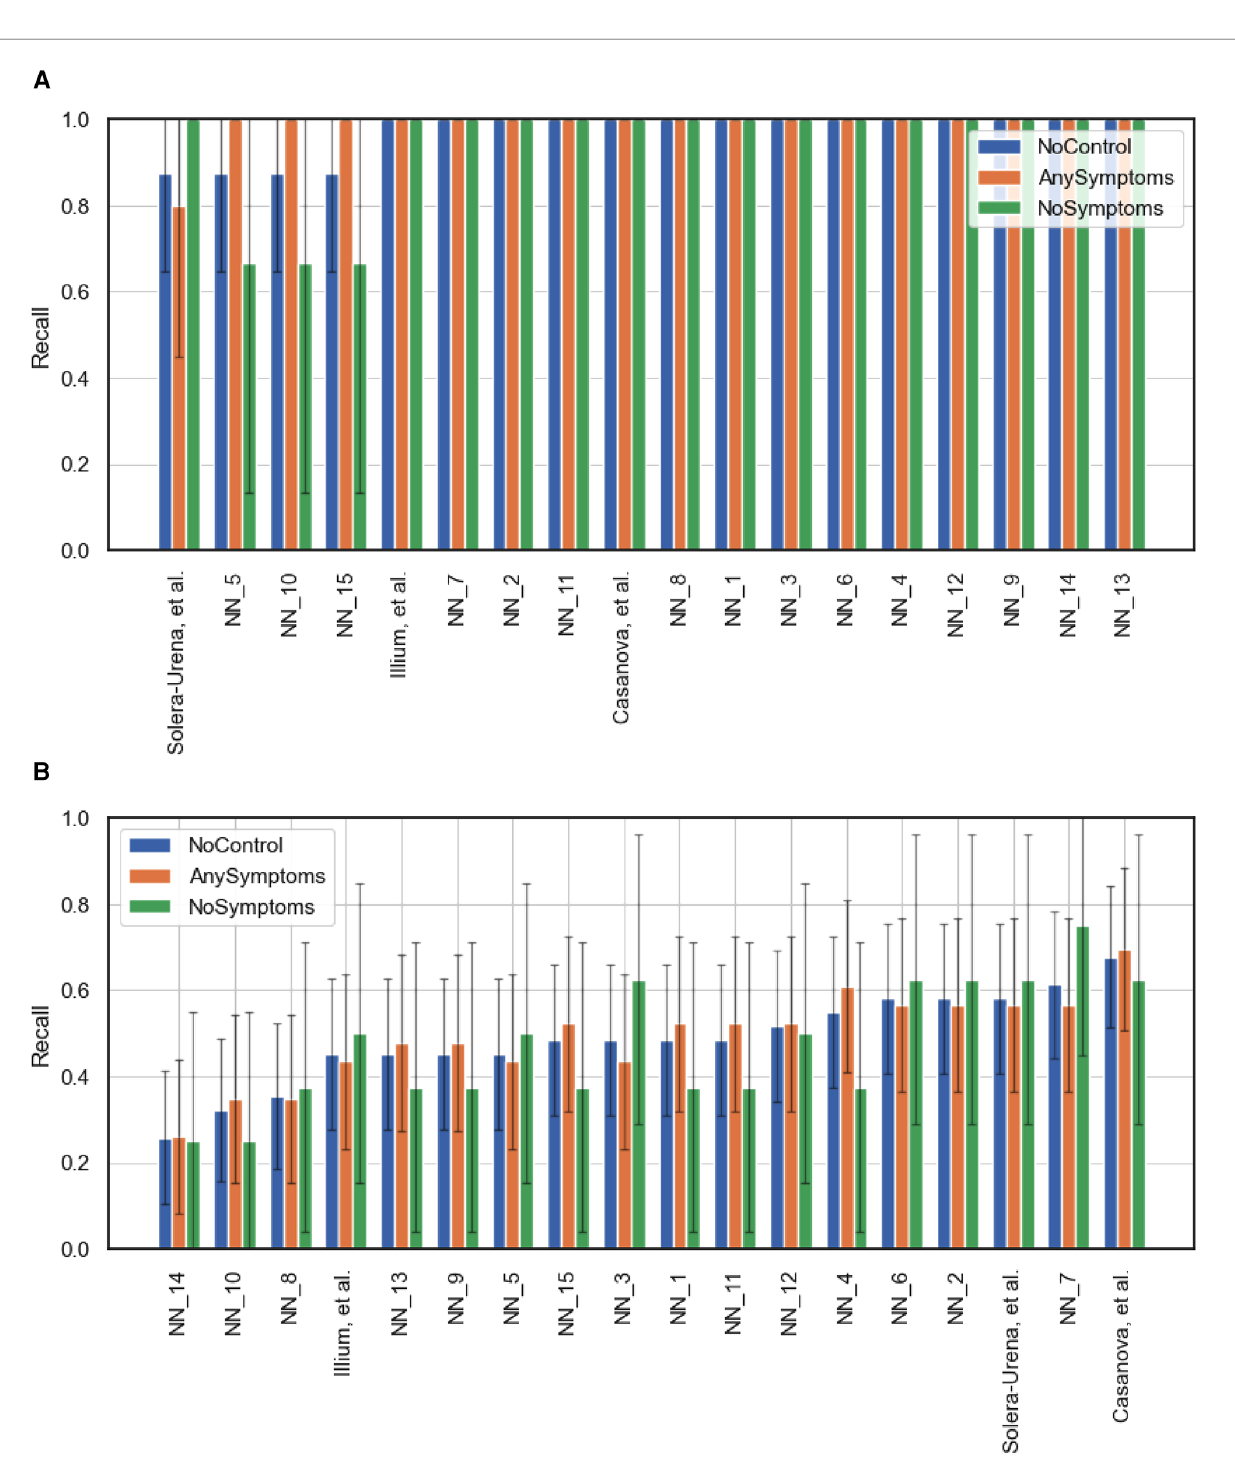
FIGURE A6 Team performance on two curated test sets from the COVID-19 Cough Sub-Challenge. ( A ) Controls for test samples with a sample rate of greater than 12kHz and ( B ) controls for test samples with a sample rate of 12kHz and below. The metric reported is recall for positive cases. 95% con fi dence intervals are shown, calculated via the normal approximation